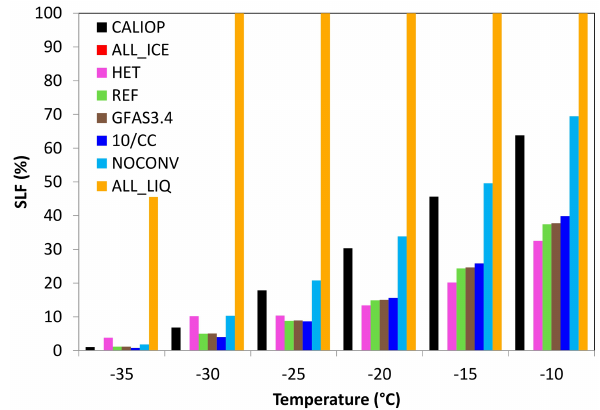
Figure 3. Frequency of occurrence of SLF in percent for clouds with COD < 3 in different temperature bins from CALIOP obser- vations for the years 2006–2010 and the various sensitivity simu- lations from the atmosphere-only present-day simulations for the years 2003–2012 described in Table